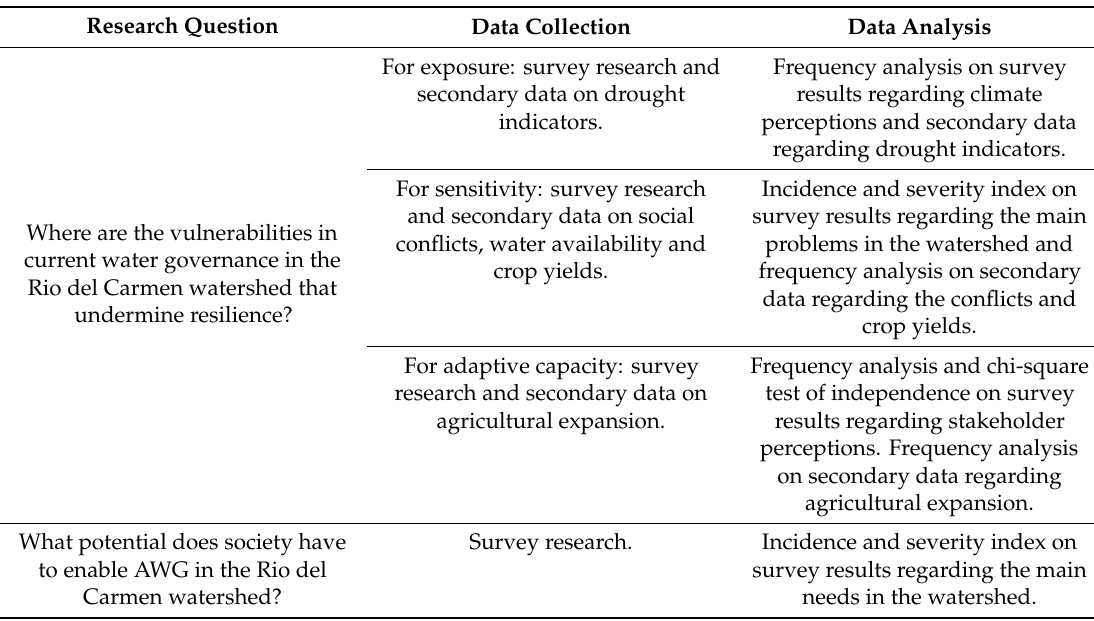
Table 1. Methods used for collecting and analysing the data needed for answering the main research